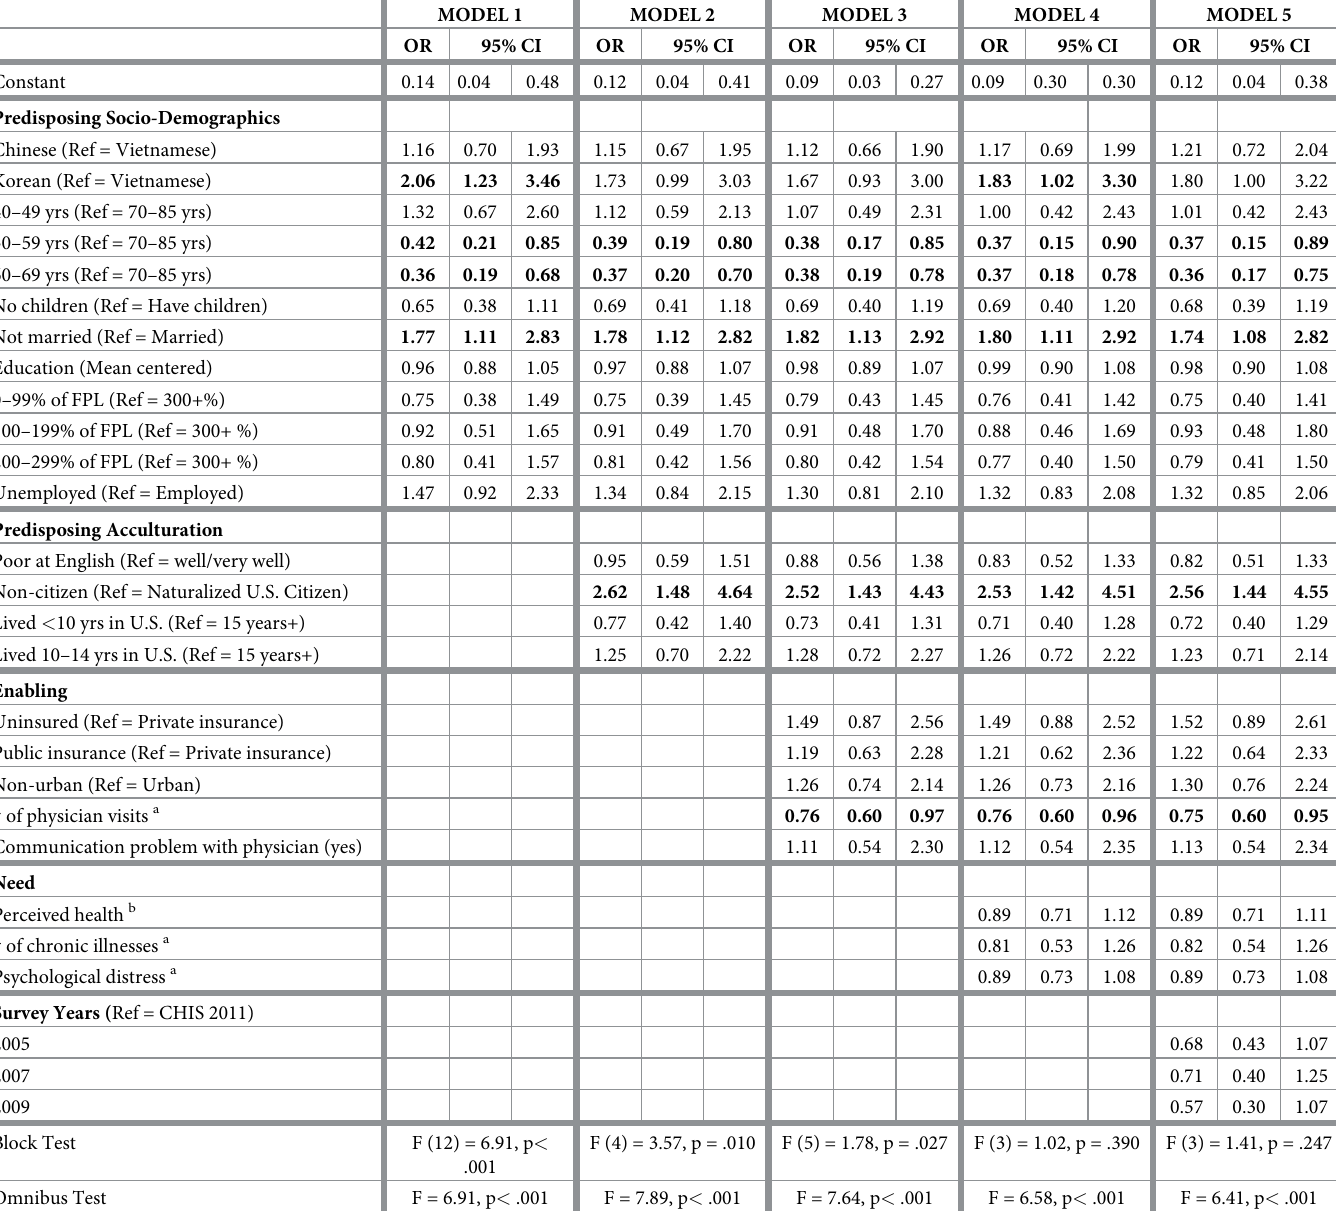
Table 3. Multivariate logistic regression models predicting odds of never having a mammogram for the three groups of Asian immigrant women (unweighted N = 3,710; weighted N =